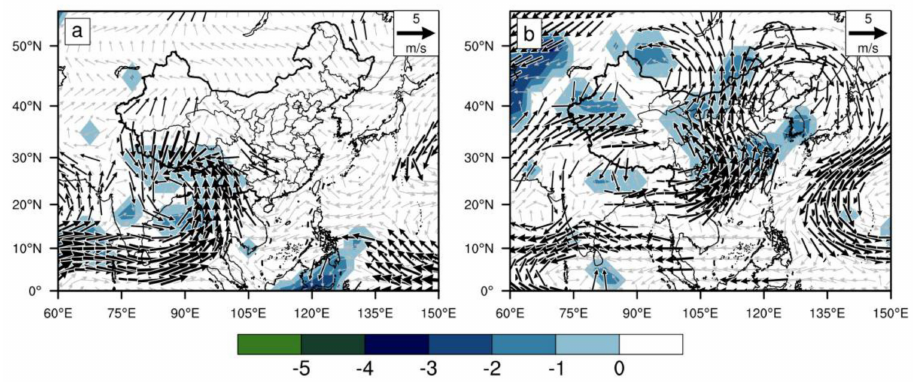
Figure 3. ( a ) Regressed anomalies of interannual components of the integral water vapor flux (vectors, unit: kg m − 1 s − 1 ) and vapor flux divergence (shading, unit: 10 − 6 kg m − 2 s − 1 ) of the whole layer (1000–300 hPa) in late spring onto the interannual components of the PC1 for the period of 1960 to 2018. ( b ) As in ( a ), but for PC2. The bold arrows denote that the U or V component of the wind anomalies have exceeded the 95% confidence